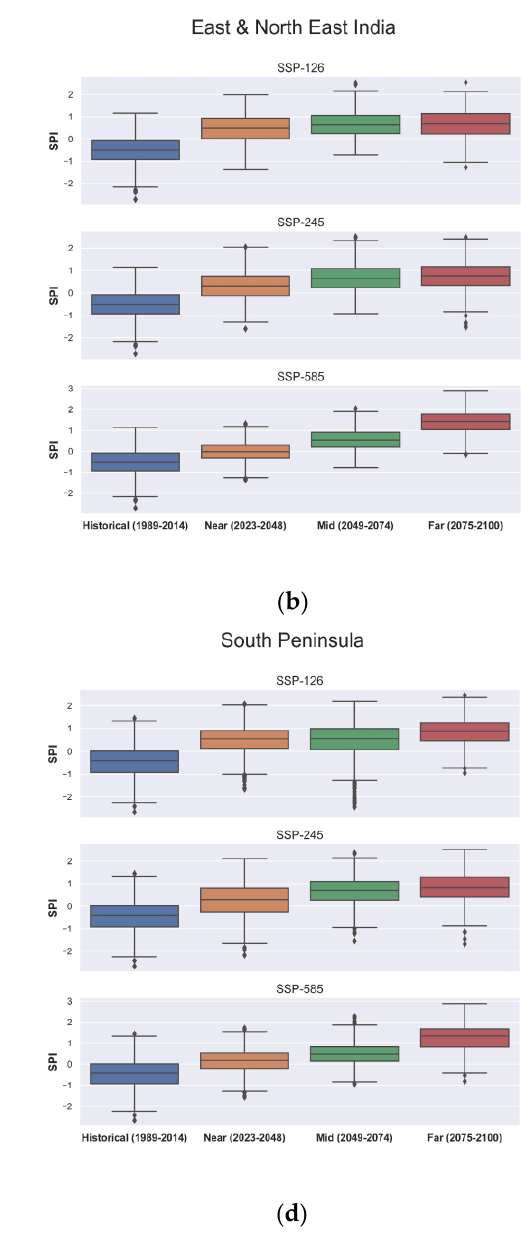
Figure 9. CMIP6 SSP scenarios 12-month Standard Precipitation Index (SPI) boxplot at homogeneous region level ( a ) Central India, ( b ) East and Northeast India, ( c ) Northwest India, and ( d ) South Peninsula India for near, mid, and far future.